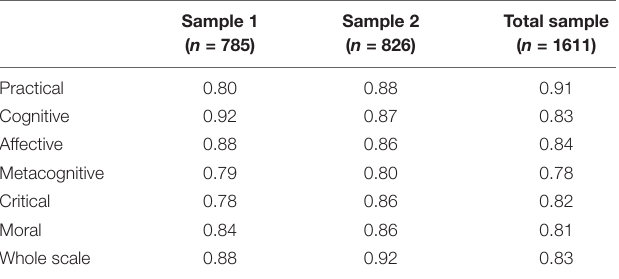
TABLE 3 | Cronbach’s alpha coefficients of the adapted ELTRI and its subscales in sample 1, sample 2 and the total